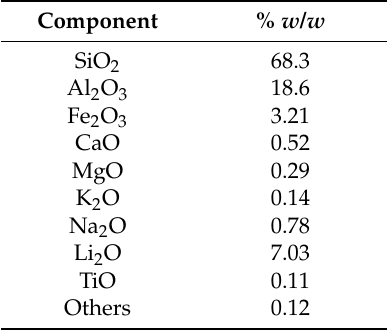
Table 1. The bulk composition of the ore.